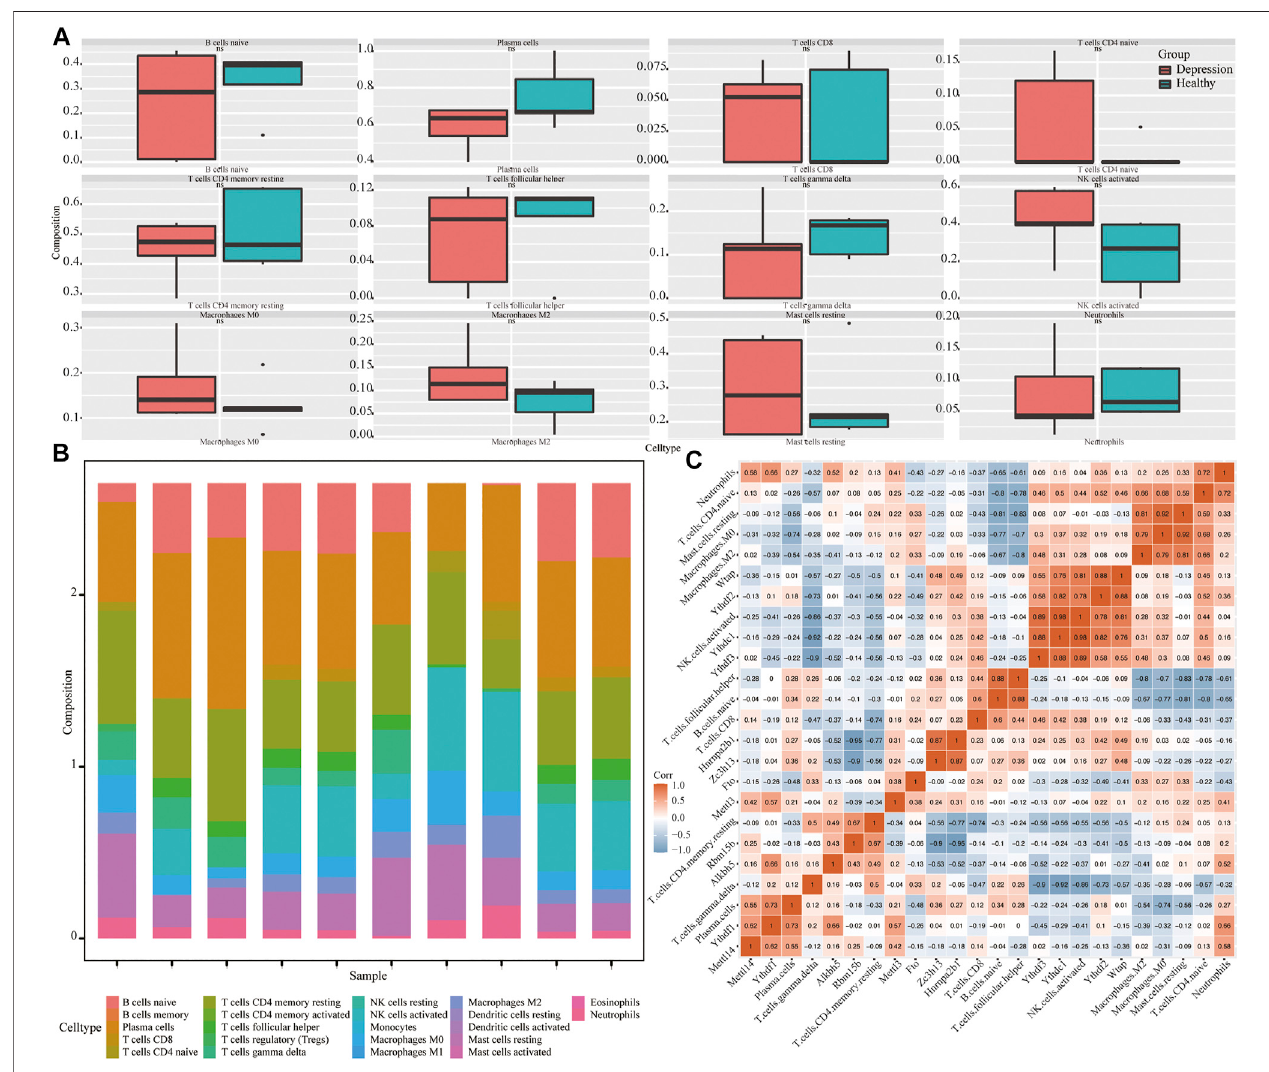
FIGURE 9 | Analysis of immune in fi ltration in depression. (A) Differential expression of in fi ltrating immune cells in experimental and control groups. (B) Overall expression of in fi ltrating immune cells. (C) Correlation heat map of hub genes and immune-in fi ltrating cells.